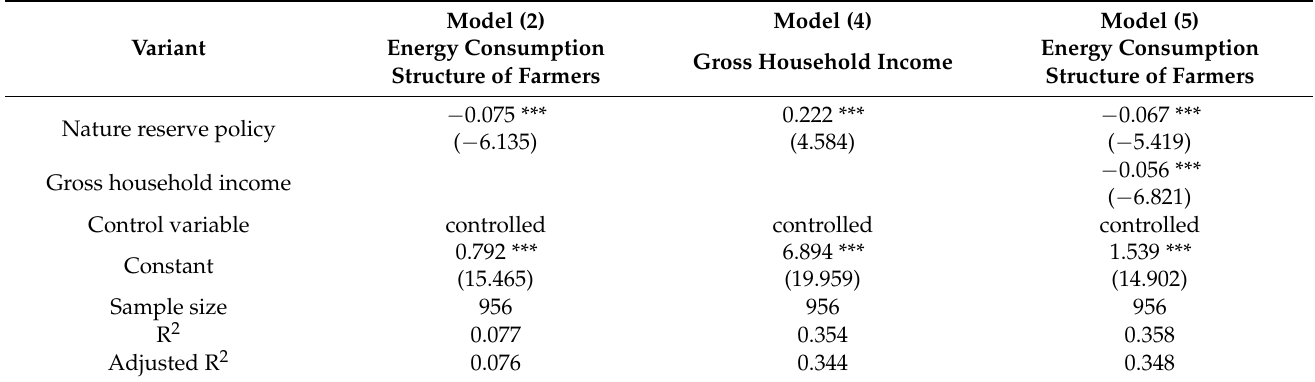
Table 6. Results of the mediation effect